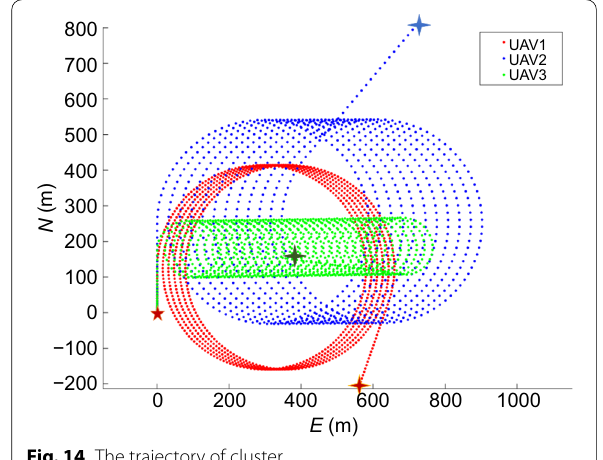
Fig. 14 The trajectory of